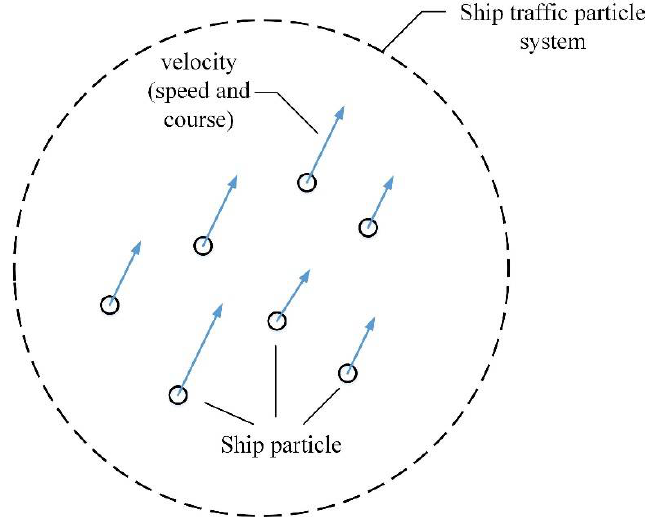
Figure 2. The ship molecules and ship traffic particle